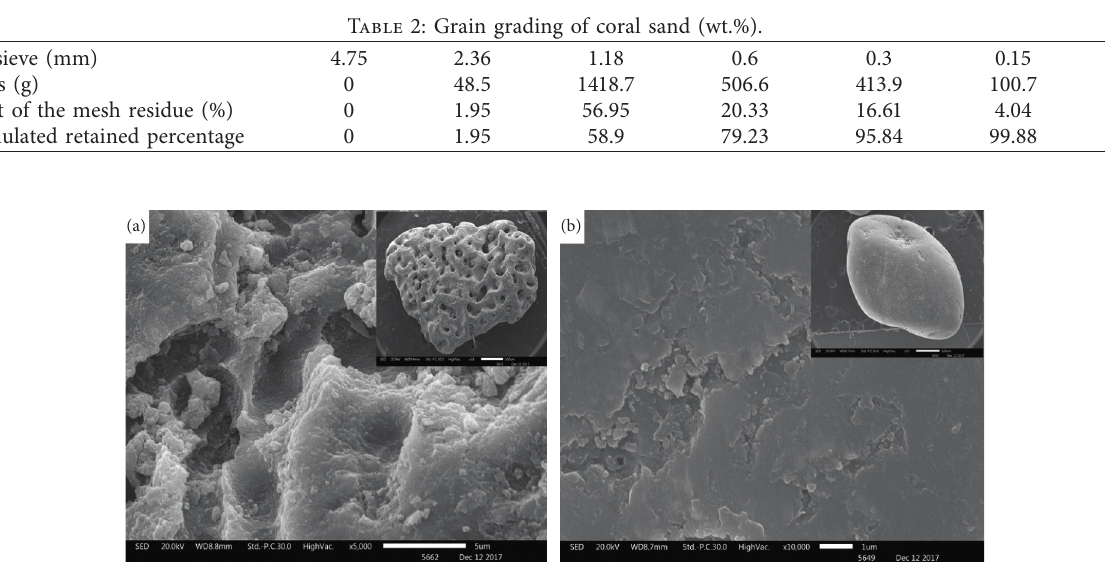
Figure 1: SEM images of the mortar aggregate. (a) Crushed coral sand. (b) Standard Table 3: Mix proportions of mortar samples (g).